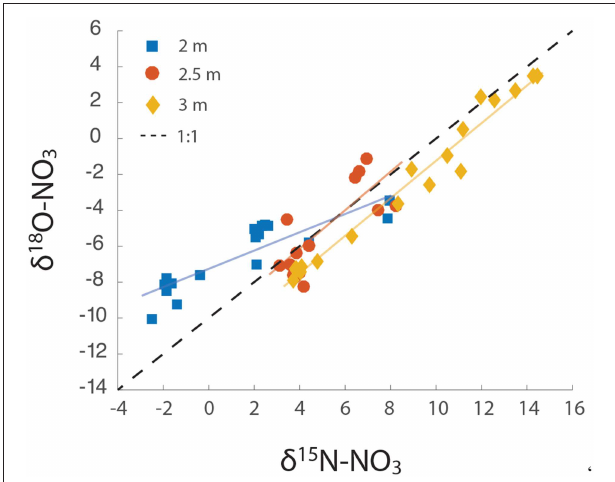
FIGURE 4 | 1δ 18 O: 1δ 15 N over the course of the groundwater rise. The slope of each line was calculated as 2 m = 0.58, 2.5 m = 1.08, and 3 m = 1.05.